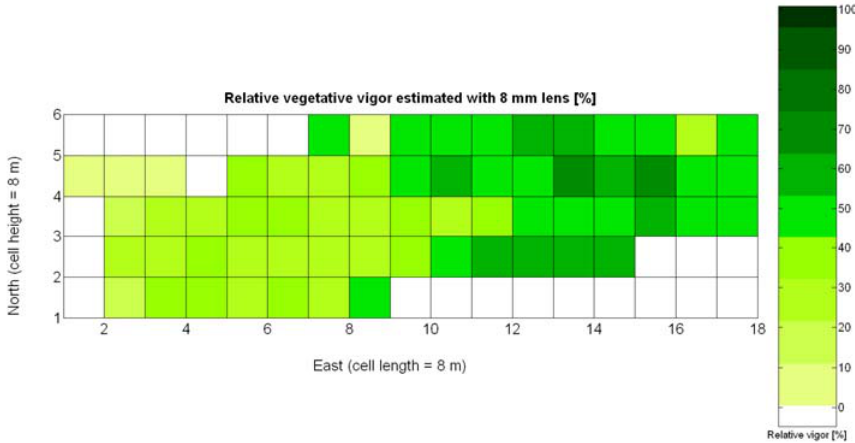
Figure 28. Low resolution CB map of relative vine vigor estimated with an 8 mm lens: V-8 (%).